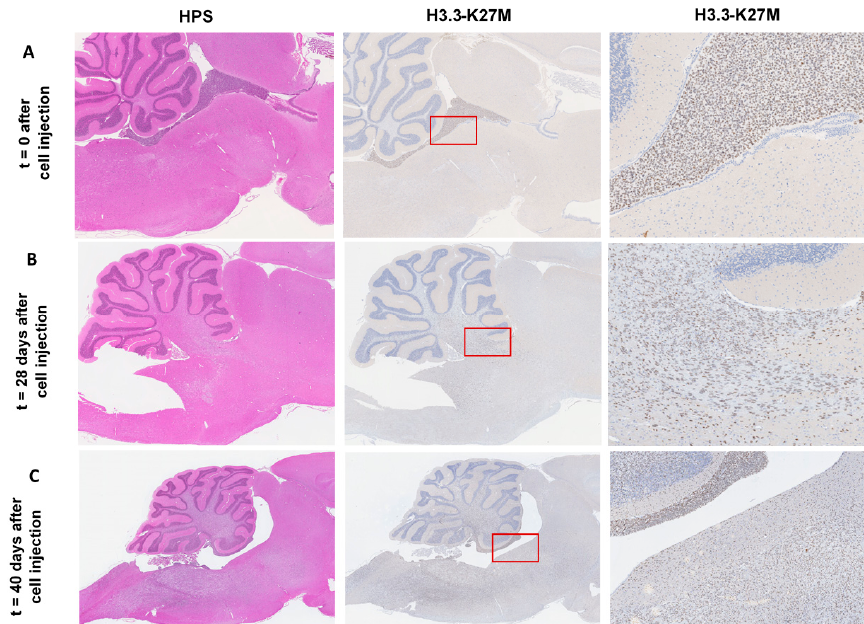
Figure 1. Evaluation of correct di ff use intrinsic pontine glioma (DIPG) cell implantation and tumor development for the establishment of DIPG xenografts in RH-Foxn1rnu nude rats. ( A ) Sagittal rat brain section with HPS (hematoxylin phloxine sa ff ron staining, left panel, 60 × magnification) and immunohistochemistry (IHC) staining for H3.3-K27M (middle and right panel, 60 × and 400 × magnification, respectively, brown nuclei-stained cells) at D0 show correct DIPG cell injection into the 4 th ventricle of the rat brain. ( B ) Sagittal rat brain section with HPS (left panel, 60 × magnification) and IHC staining for H3.3-K27M (middle and right panel, 60 × and 400 × magnification, respectively, brown nuclei-stained cells) at D28 show DIPG cells largely di ff used into the brainstem and cerebellum 4 weeks after DIPG cell implantation into the 4th ventricle of the rat brain. ( C ) Sagittal rat brain section with HPS (left panel, 40 × magnification) and IHC staining for H3.3-K27M (middle and right panel, 40 × and 200 × magnification, respectively, brown nuclei-stained cells) at D40 show an increasing degree of infiltration of DIPG cells and necrosis of the brain